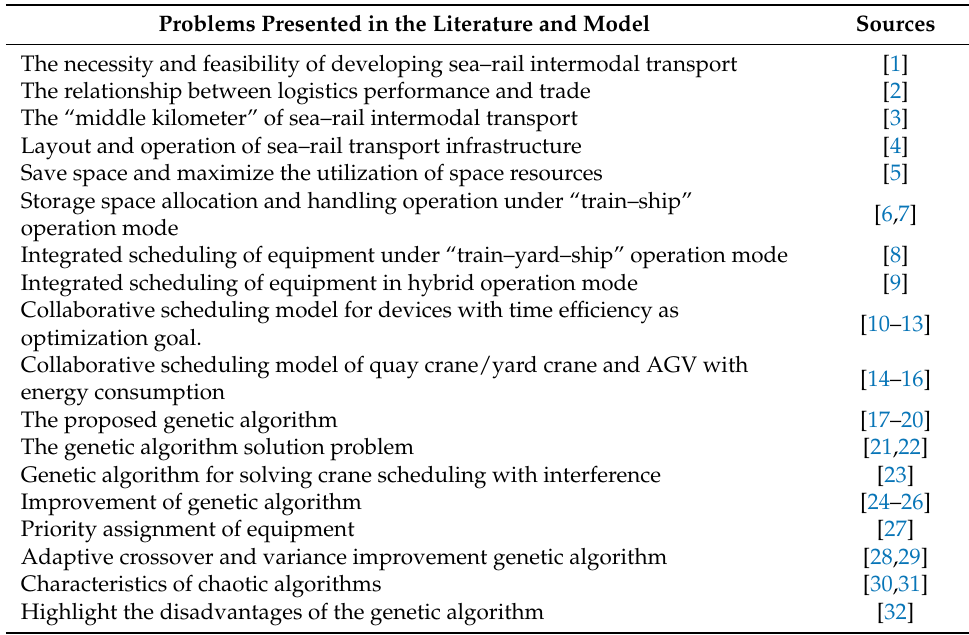
Figure 1. Railway vertical port layout diagram. Table 1. Literature sources used in the article.